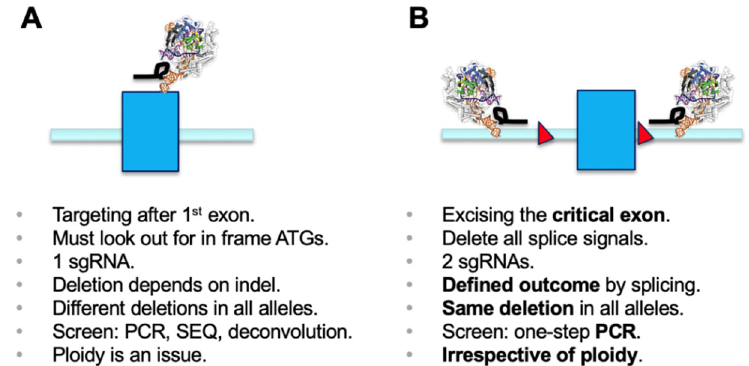
Figure 1. Two di ff erent approaches using CRISPR / Cas9 for achieving a functional KO, highlighting the di ff erences that need to be considered. Exons are depicted as blue rectangles, splice branch and donor sites are indicated as red rectangles, and the crystal structure with the black loop indicates Cas9 and sgRNA. ( A ) Use of a single validated sgRNA relies on introducing a frameshift by NHEJ-mediated indel formation. When designing such guides, care must be taken to avoid later in-frame re-initiation of translation. Most alleles will have distinct deletion outcomes. Screening for mutants relies on PCR, sequencing and deconvolution of sequencing reads. More than diploid cell lines can be di ffi cult to screen. The big advantage is ease (only one validated sgRNA is required) and least potential OFF-targeting. ( B ) Excision of a designated critical exon to generate a KO delivers a defined outcome of all clones that have been PCR screened for presence of the desired deletion. The same outcome will be obtained in all alleles due to exon ablation and subsequent aberrant splicing. The indel status in the intronic region generally does not contribute to any phenotype. A one-step PCR screen can identify mutations irrespective of ploidy.